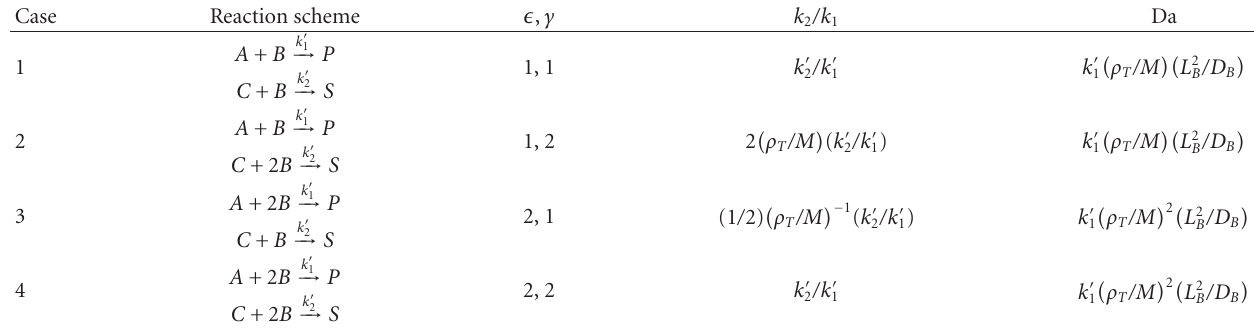
Table 3: Stoichiometries of reaction schemes and the corresponding dimensionless reaction rate ratio and Damk¨ohler number for the four di ff erent C-P